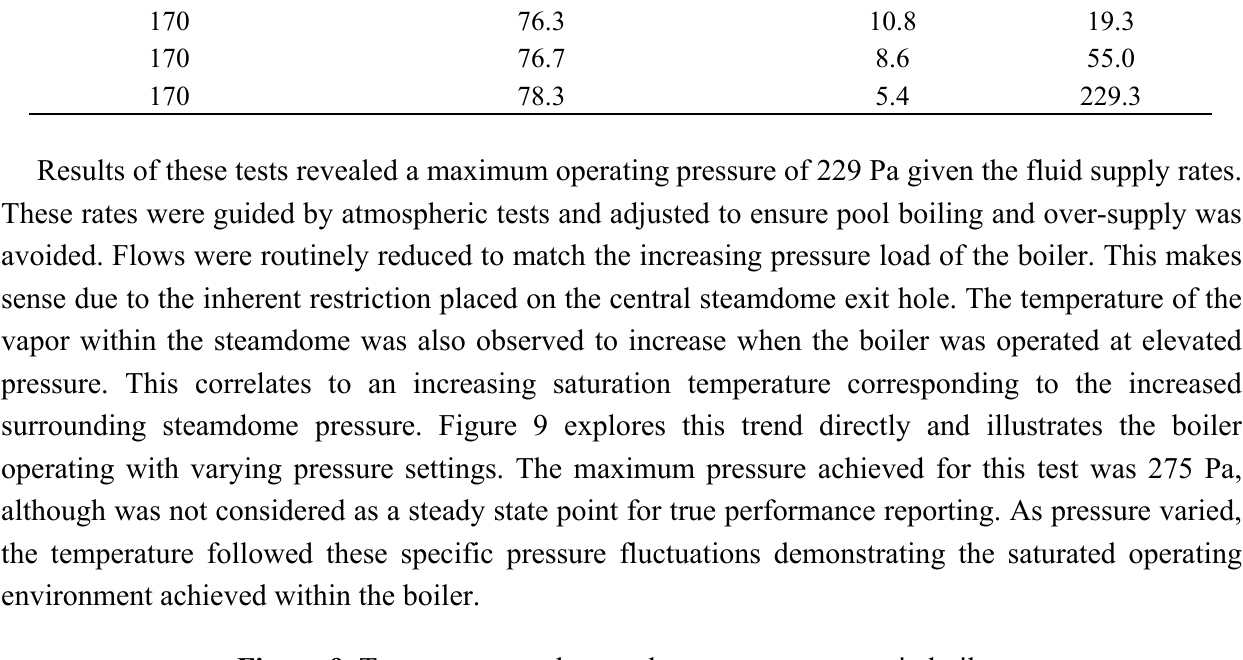
Figure 9. Temperature and steamdome vapor pressure in